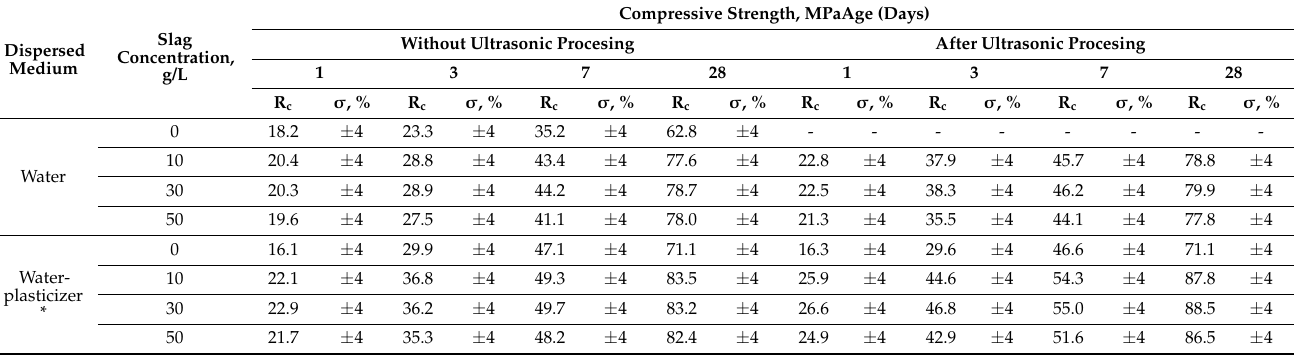
Table 25. Strength characteristics of OPC-based samples with slag